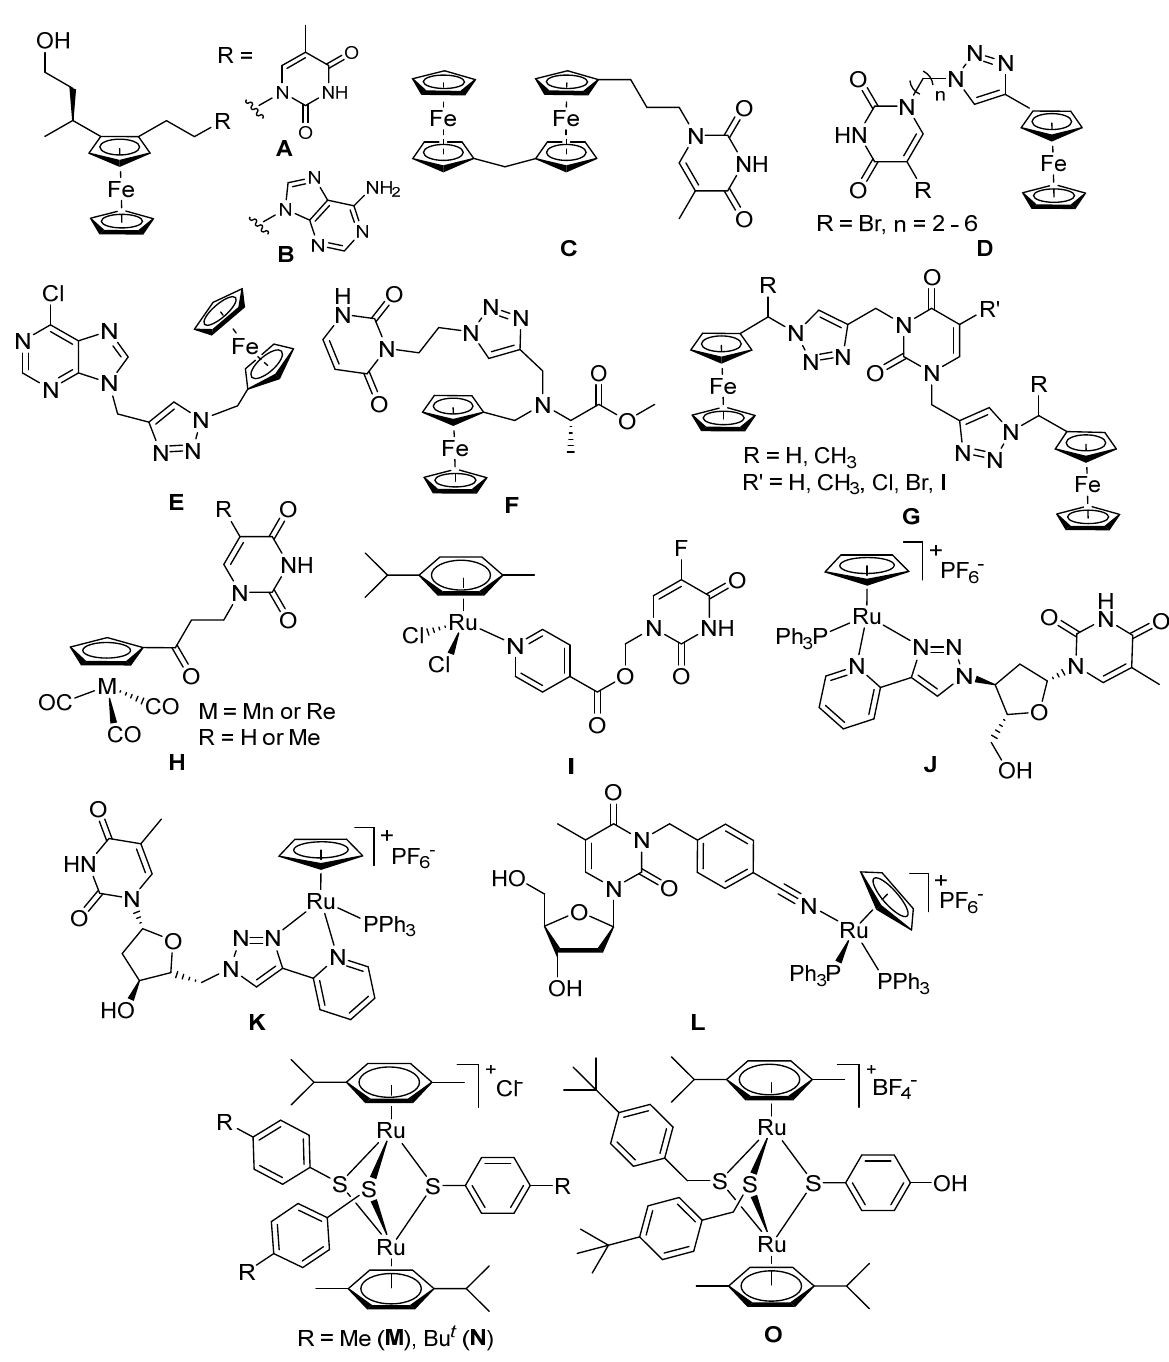
Figure 1. Structure of various conjugates organometallic complex nucleobase/nucleoside ( A – L ), and of symmetric ( M , N ) and mixed ( O ) trithiolato-bridged ruthenium(II)-arene complexes. For example, thymine and adenine ferrocene derivatives A and B [78,79] and di- ferrocene–uracil compound C [80] showed promising anticancer activity and good selec- tivity. Copper-catalyzed azide-alkyne [3+2] cycloaddition (CuAAC) was used to prepare antitubercular agent D [81], anticancer compound E [82], and antifungal derivative F [72]. CuAAC click reactions also afforded cytostatic bis-ferrocene conjugates G bridged by 1,2,3-triazole linkers to 5-substituted uracil [83]. Cymantrene and cyrhetrene uracil and thymine conjugates H showed promising activity against Trypanosoma brucei and good selectivity [84], and 5-fluorouracil ruthenium(II)-arene compound I exhibited